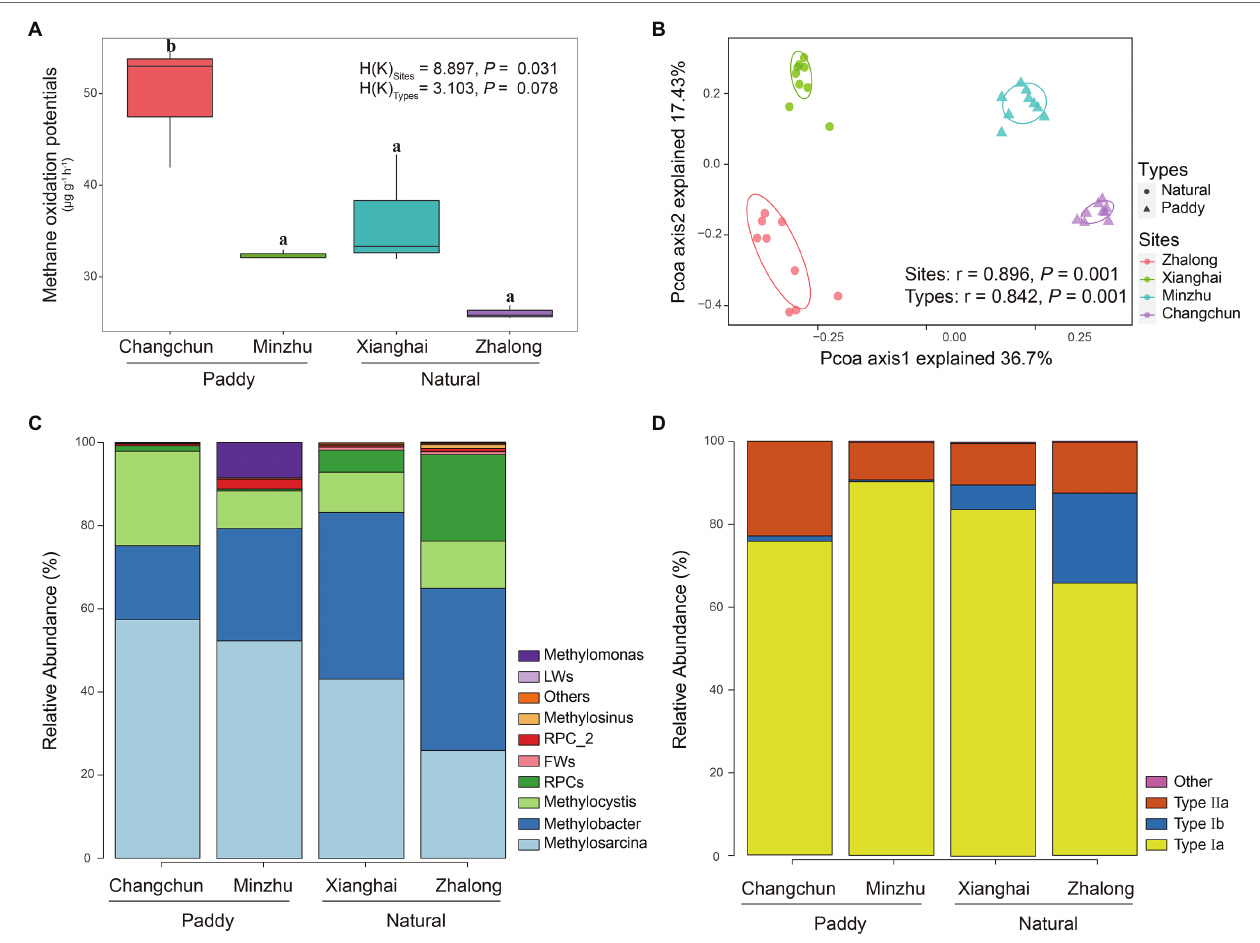
FIGURE 2 | (A) Methane oxidation potentials at the CH 4 incubations of four wetland soils. Boxes with different lowercase letters represent significant differences ( p < 0.05). (B) Principal coordinates analysis (PCoA) biplots of Bray–Curtis distances for the active methanotrophic communities of four wetland soils. (C,D) Relative abundance of active methanotrophs on the genus levels and methanotrophic category levels identified with pmoA gene sequencing in four wetland